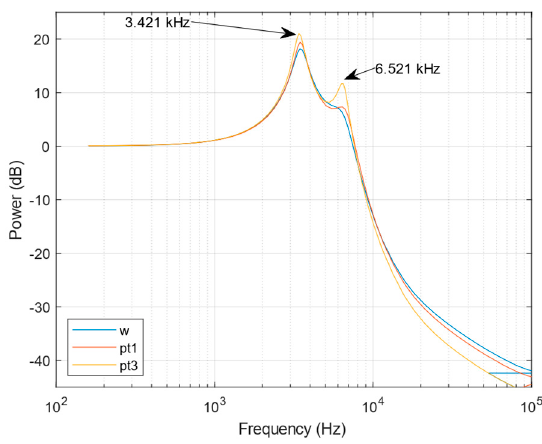
Figure 10. The frequency properties of the obtained Pitot tube models.